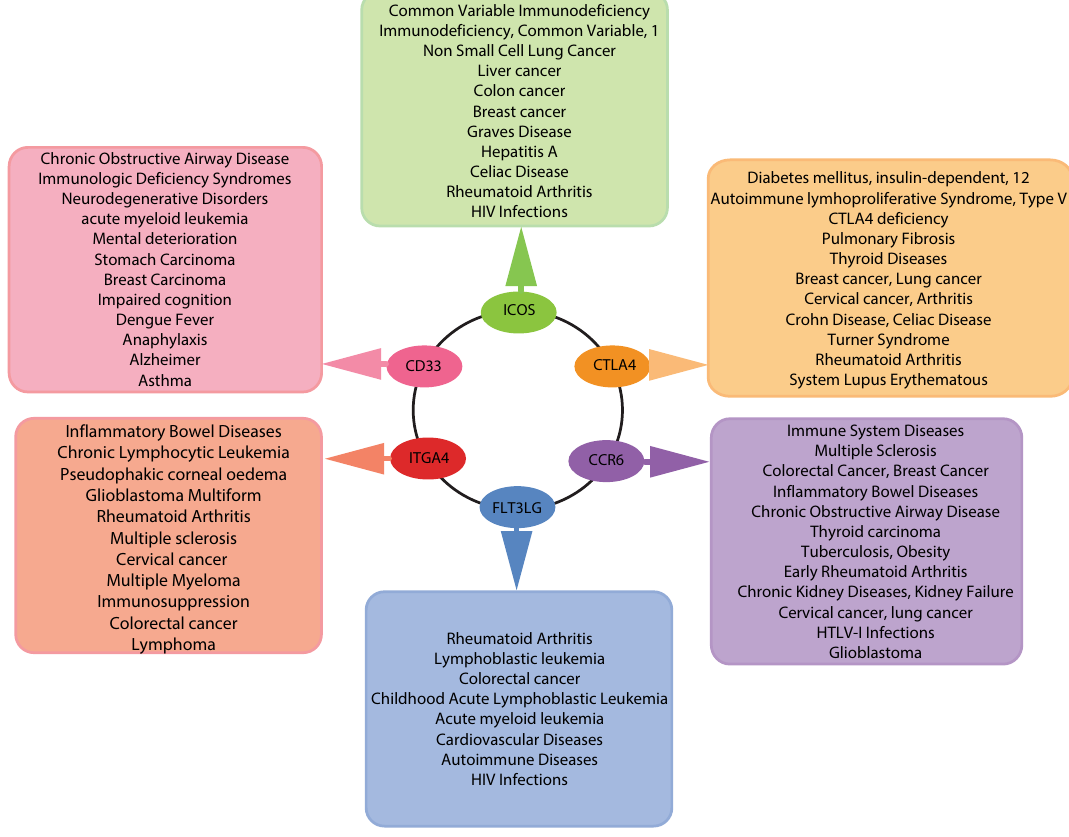
Figure 9. Representation of six key regulators involved directly or indirectly in Sarcoidosis and several other life-threatening diseases, including various types of